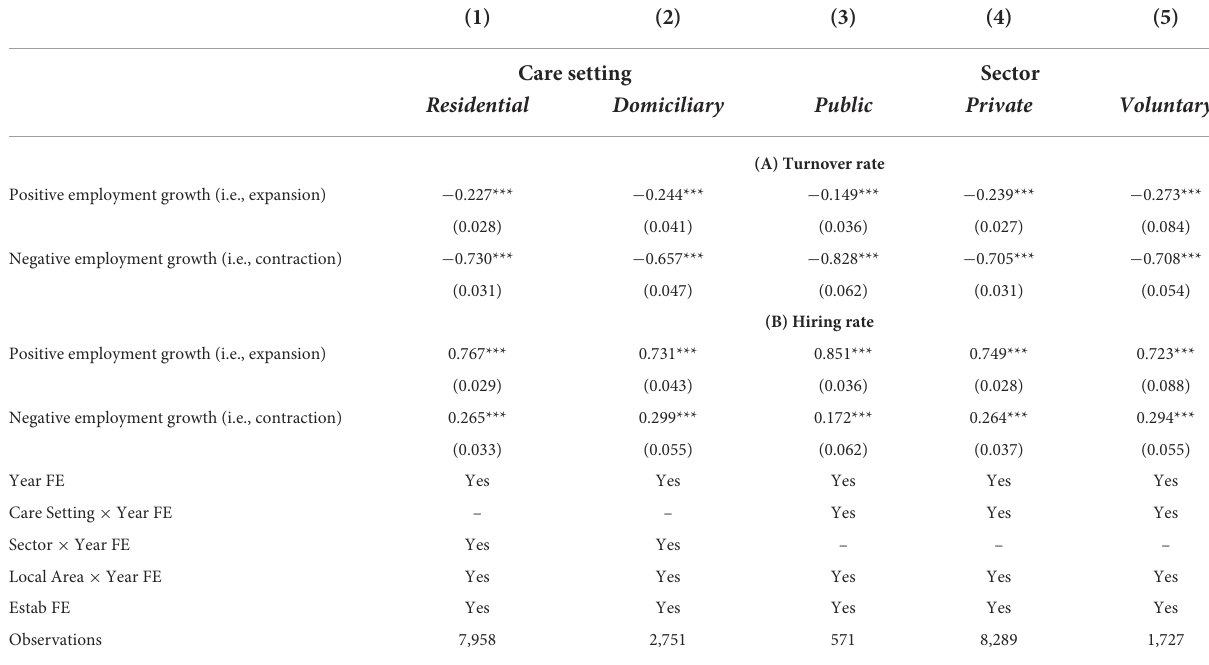
TABLE 6 Estimation results—heterogeneity across sectors and care